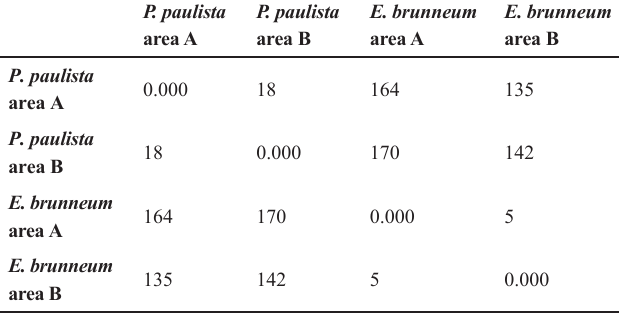
Table 1 . Squared Mahalanobis distances between groups of Polybia paulista wasps and Ectatomma brunneum ants, comparing the venom chemical composition among samples from two different areas of